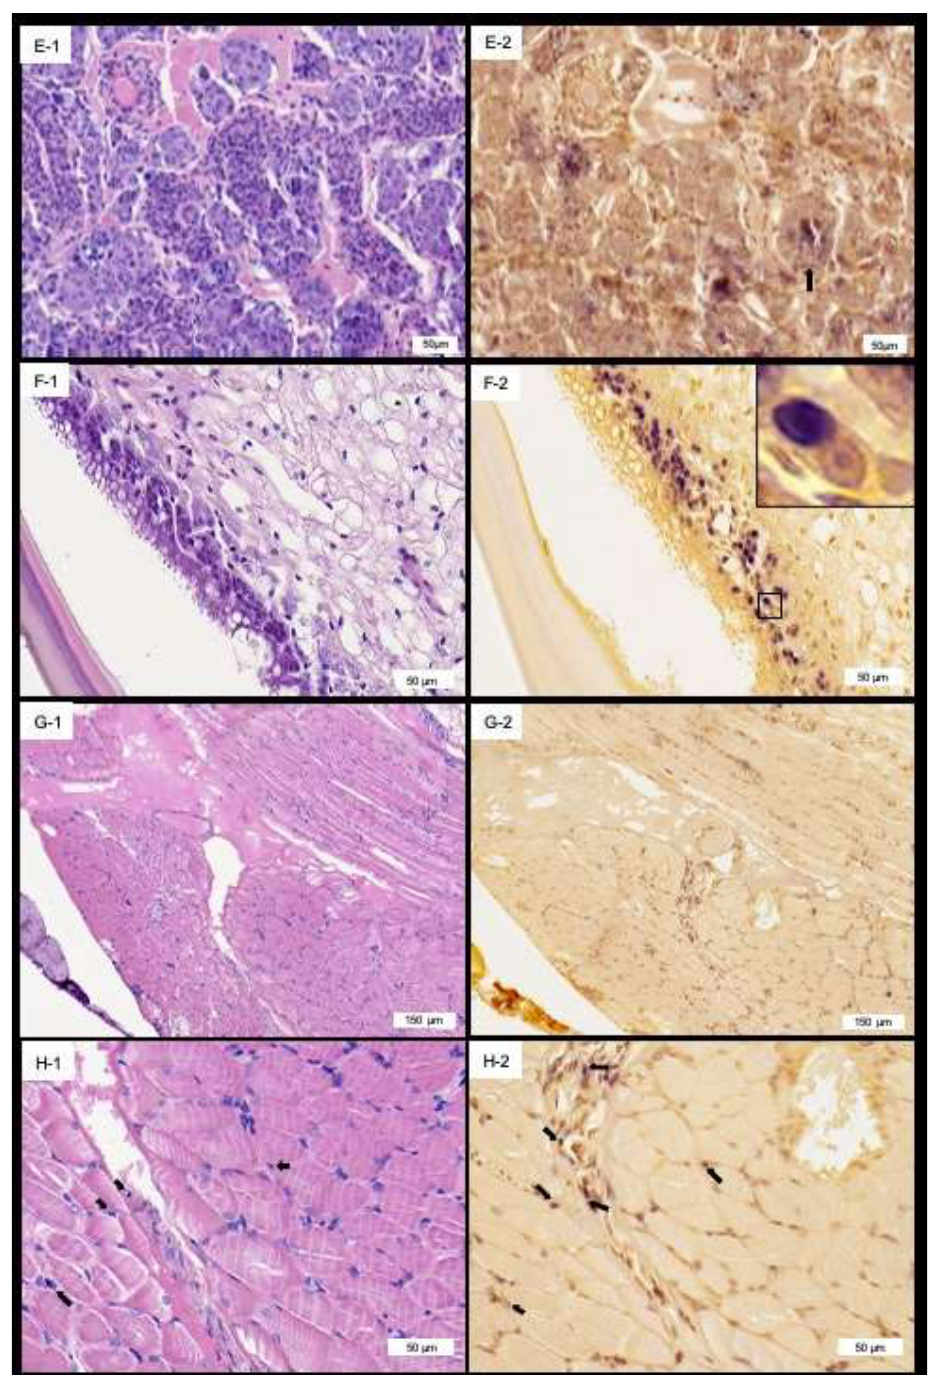
Figure 4. Hematoxylin and eosin-stained sections and in situ hybridization of parallel sections of Penaeus vannamei tissue infected with the Penaeus vannamei solinvivirus (PvSV). ( E-1 ) Lymphoid organ spheroids in diseased shrimp. ( E-2 ) Lymphoid organ spheroids showing both a cytoplasmic and nuclear reaction to the PvSV-specific probe. ( F-2 ) Gut epithelia showing a large number of intranuclear inclusions with a positive reaction to the PvSV probe, no apparent abnormalities are observed in the infected nuclei ( F-1 ). ( G-1 – H-2 ) Low and high magnification of the muscle tissue also showing a positive reaction in the nuclei. A magnified view of the box with solid line in Panel F-2 is shown in the right-hand corner of the